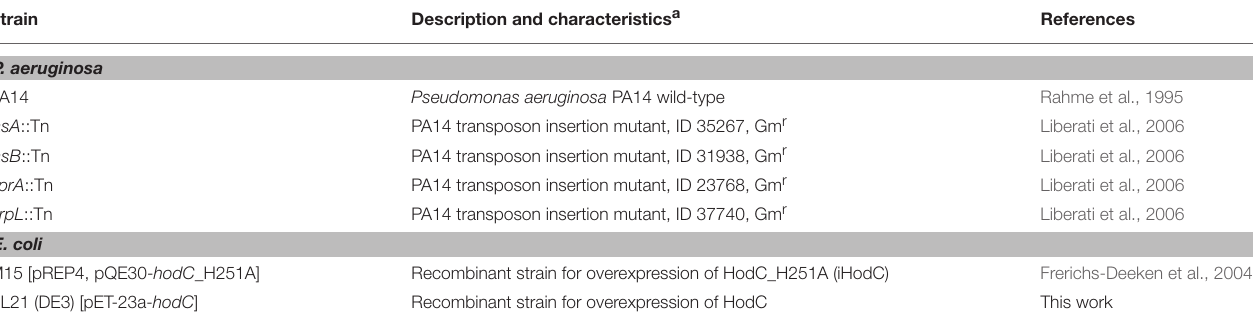
TABLE 1 | Bacterial strains used in this